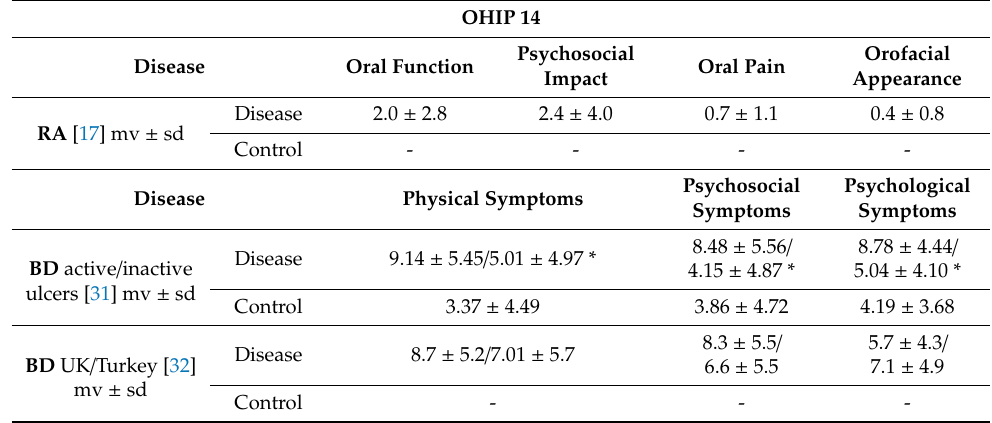
Table 4. Findings of studies which applied alternative subscales of the OHIP 14